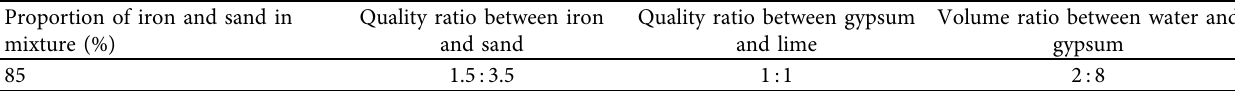
Table 4: Mixed materials finished initially.